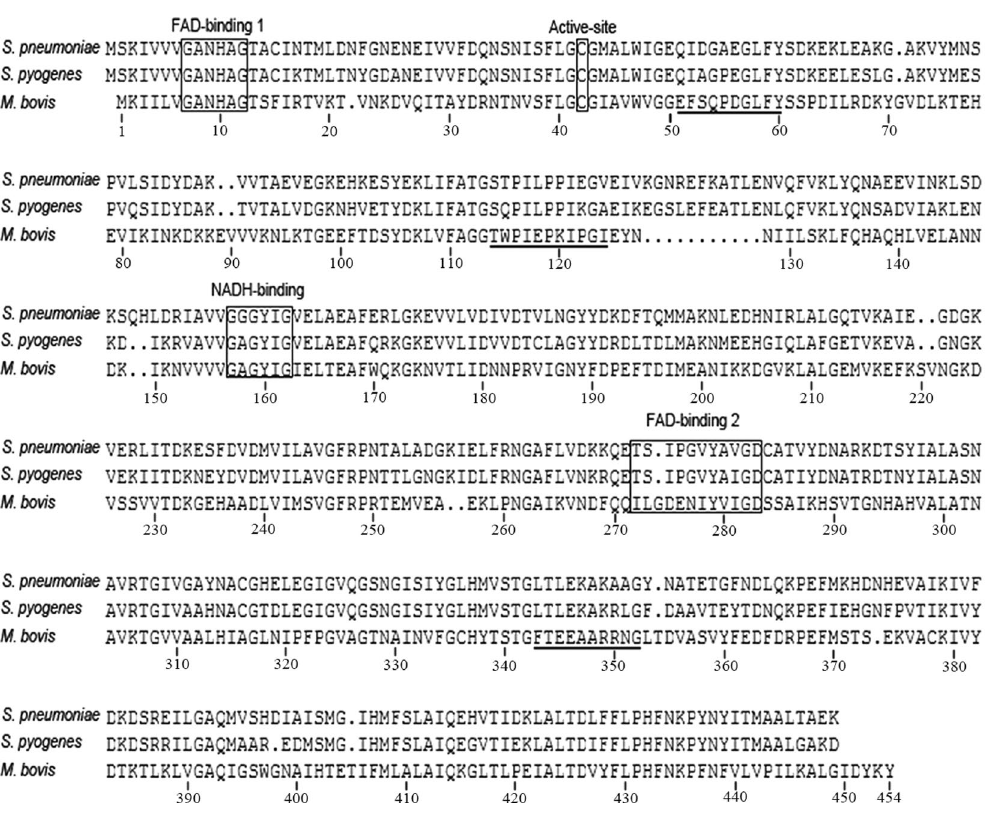
Figure 1. Comparative distribution of the motifs for enzymatic activity and B epitopes in the sequences of NADH oxidase (NOX) of M. bovis and S. pyogenes . The domains or sites for enzyme activity are indicated in box in M. bovis and S. pyogenes NOX. The B-cell epitopes predicted by BepiPred are underlined. The numbers are labeled according to the amino acid sequence of M. bovis